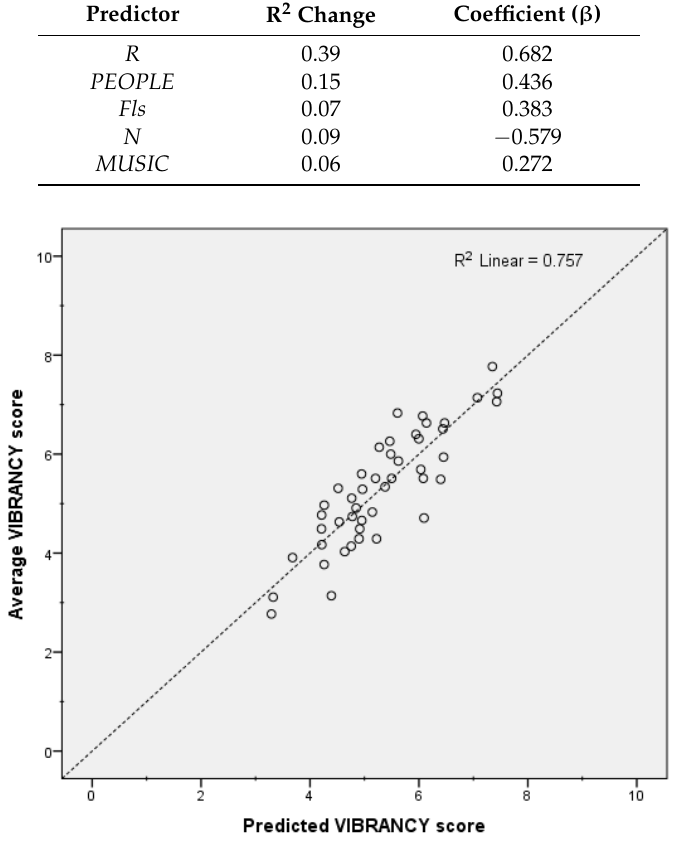
Table 4. Linear regression model for vibrancy.